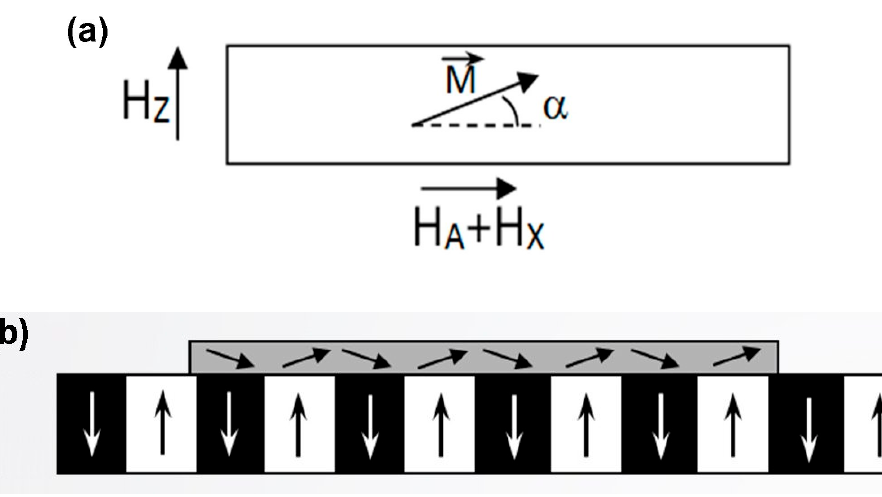
Figure 1. ( a ) Rotation of magnetization vector in MOIF under an external magnetic field. H A is the anisotropy field of the MOIF; ( b ) Rotation of magnetization in MOIF under the effect of the sample’s stray field.